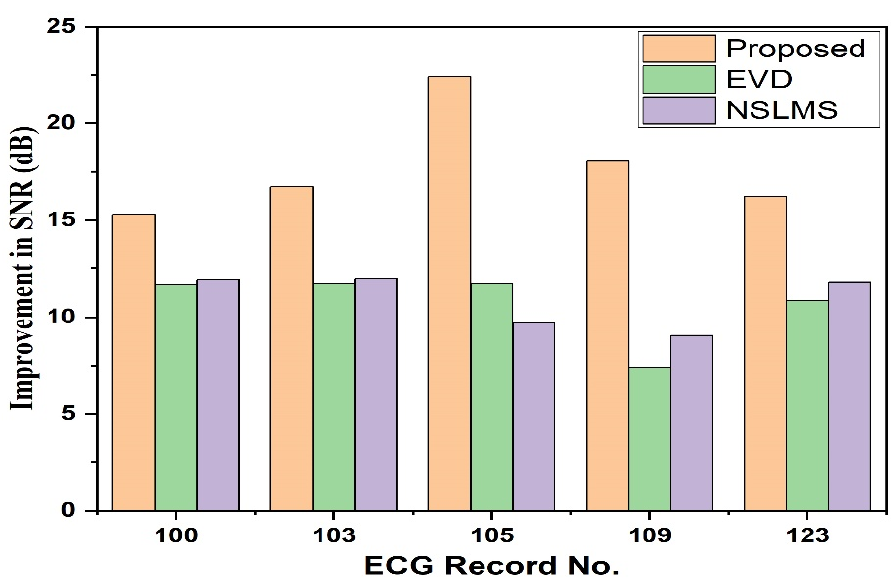
Figure 9. Comparison of the proposed method with EVD and NSLMS methods in eliminating 50 Hz PLI in terms of the improvements in the SNR values at 0 dB input SNR.